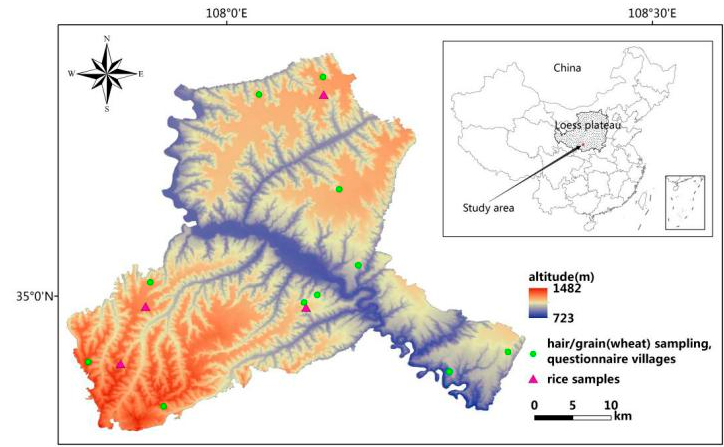
Figure 1. Distribution of sampling sites.